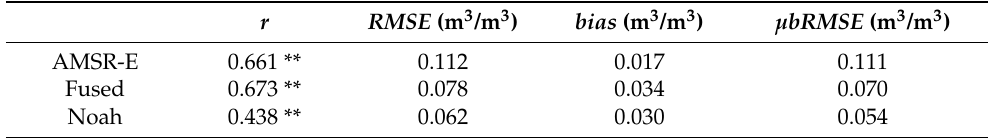
Table 3. Temporal accuracy evaluations of the AMSR-E, Noah, and the fused MODIS SSM against in situ data at SMTMN scale in unfrozen period.